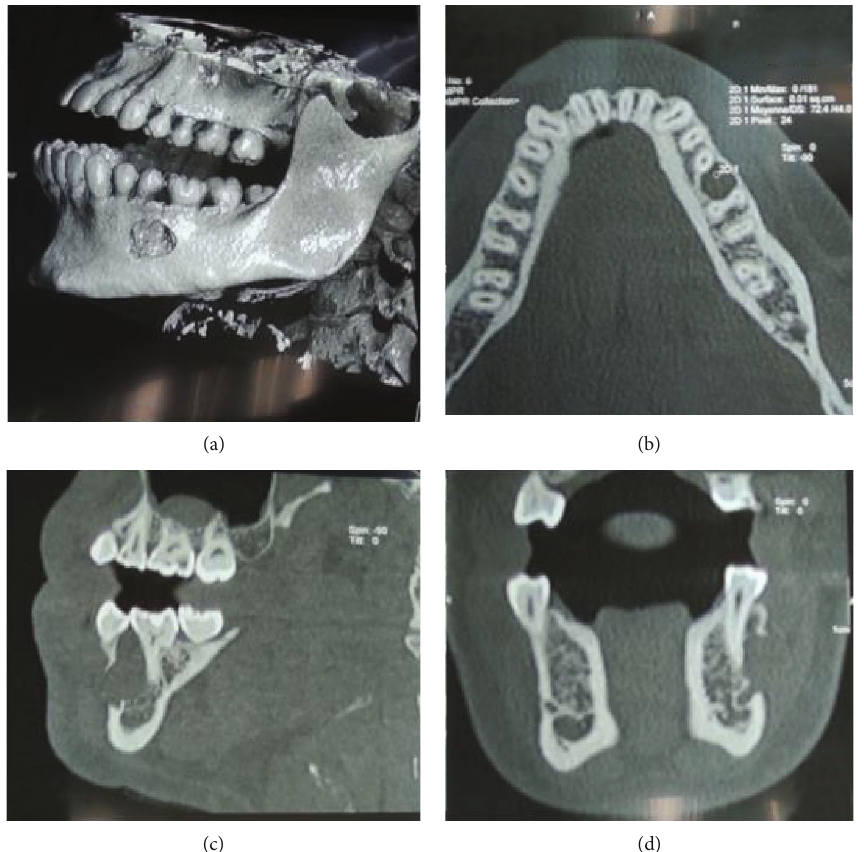
Figure 4: Dentascan radiography presenting the lesion on the left mandible on (a): a 3D reconstruction; (b): an axial view; (c): a sagittal view; and (d): a coronal view.